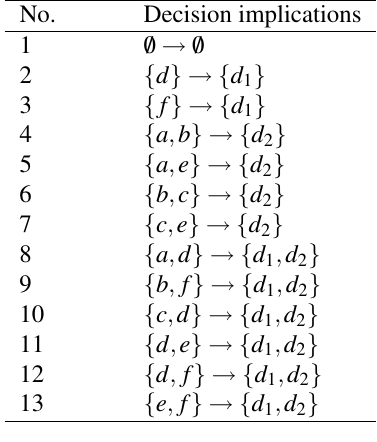
Table 3. A Π ∗ -base of K No.